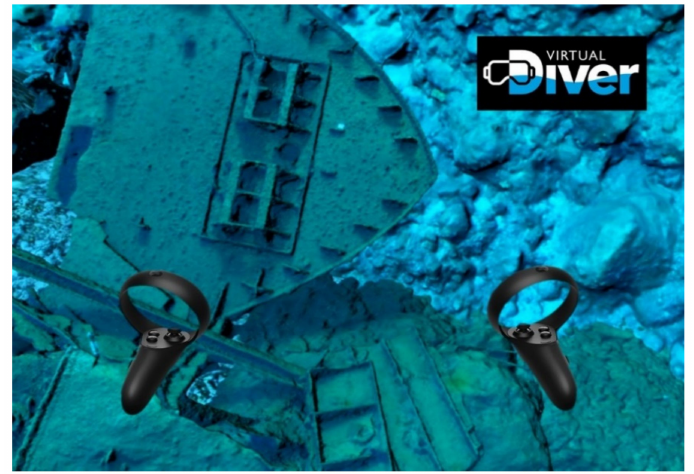
Figure 20. Diver Mode: User interacting with a 3D model of a shipwreck. (3D Model has been produced by Up2metric VIRTUALDriver